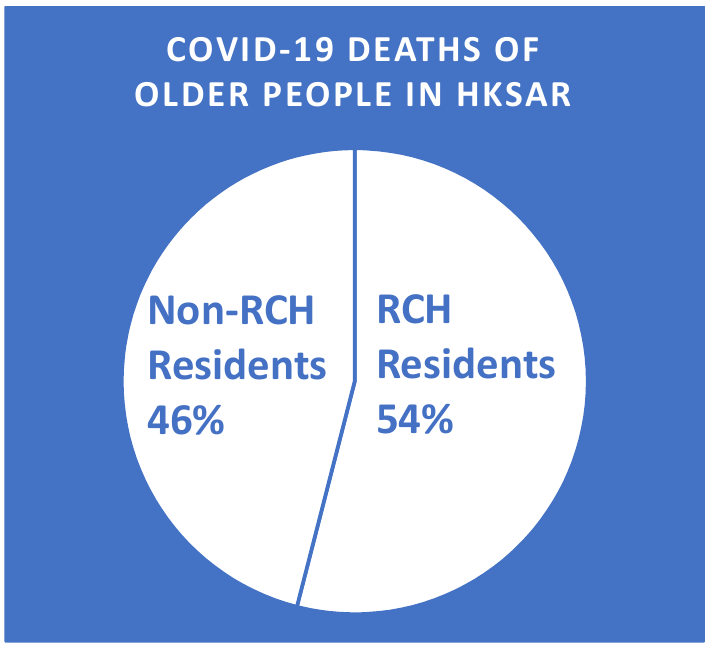
Figure 16. Residency of the COVID-19 deaths in HKSAR.